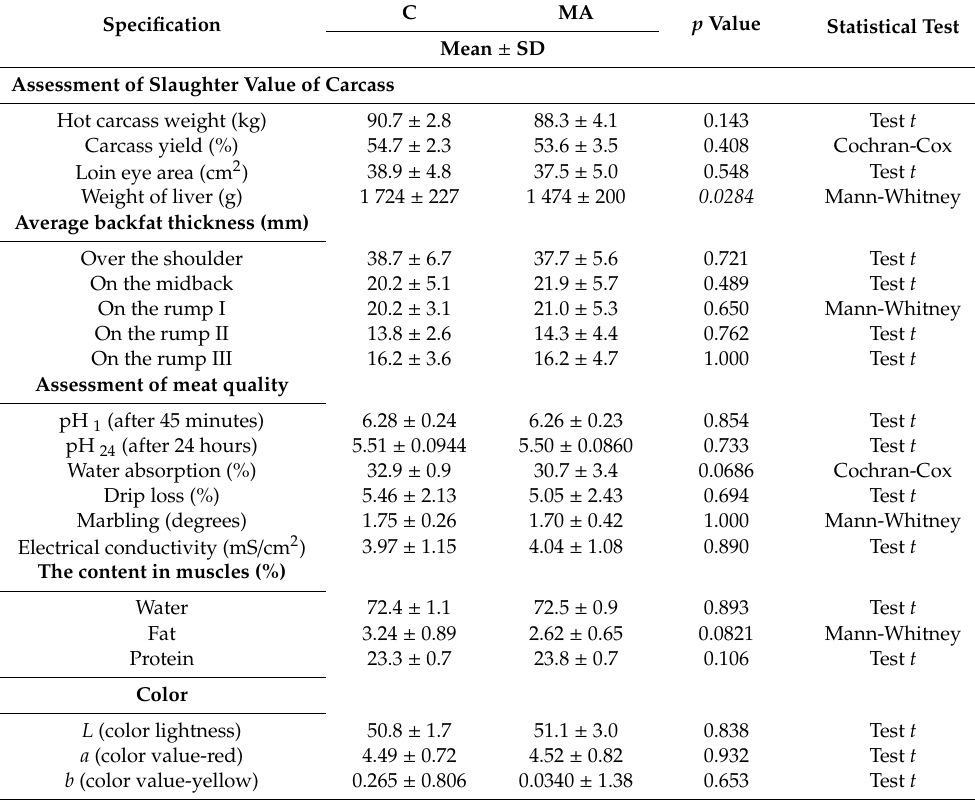
Table 6. Assessment of slaughter value of carcass and meat